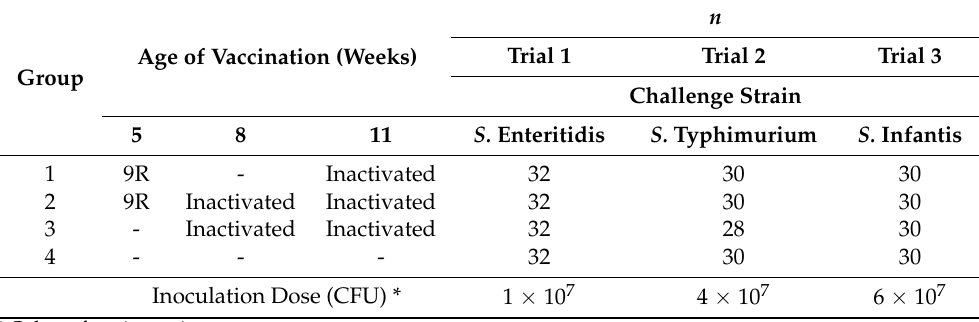
Table 1. Vaccination and challenge. Schedule and number of birds. The chickens were vaccinated with the 9R vaccine and with the trivalent inactivated vaccine. At week 14 of life, in each trial, the chickens were inoculated by gavage into the crop with 0.5 mL of the correspondent strain.